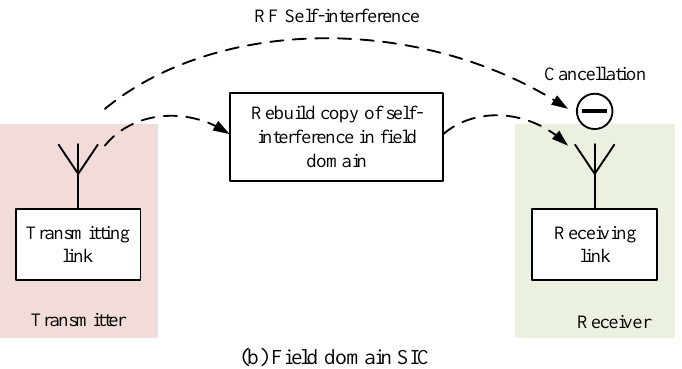
Figure 3. Distinction between the circuit- and field-domain SIC.